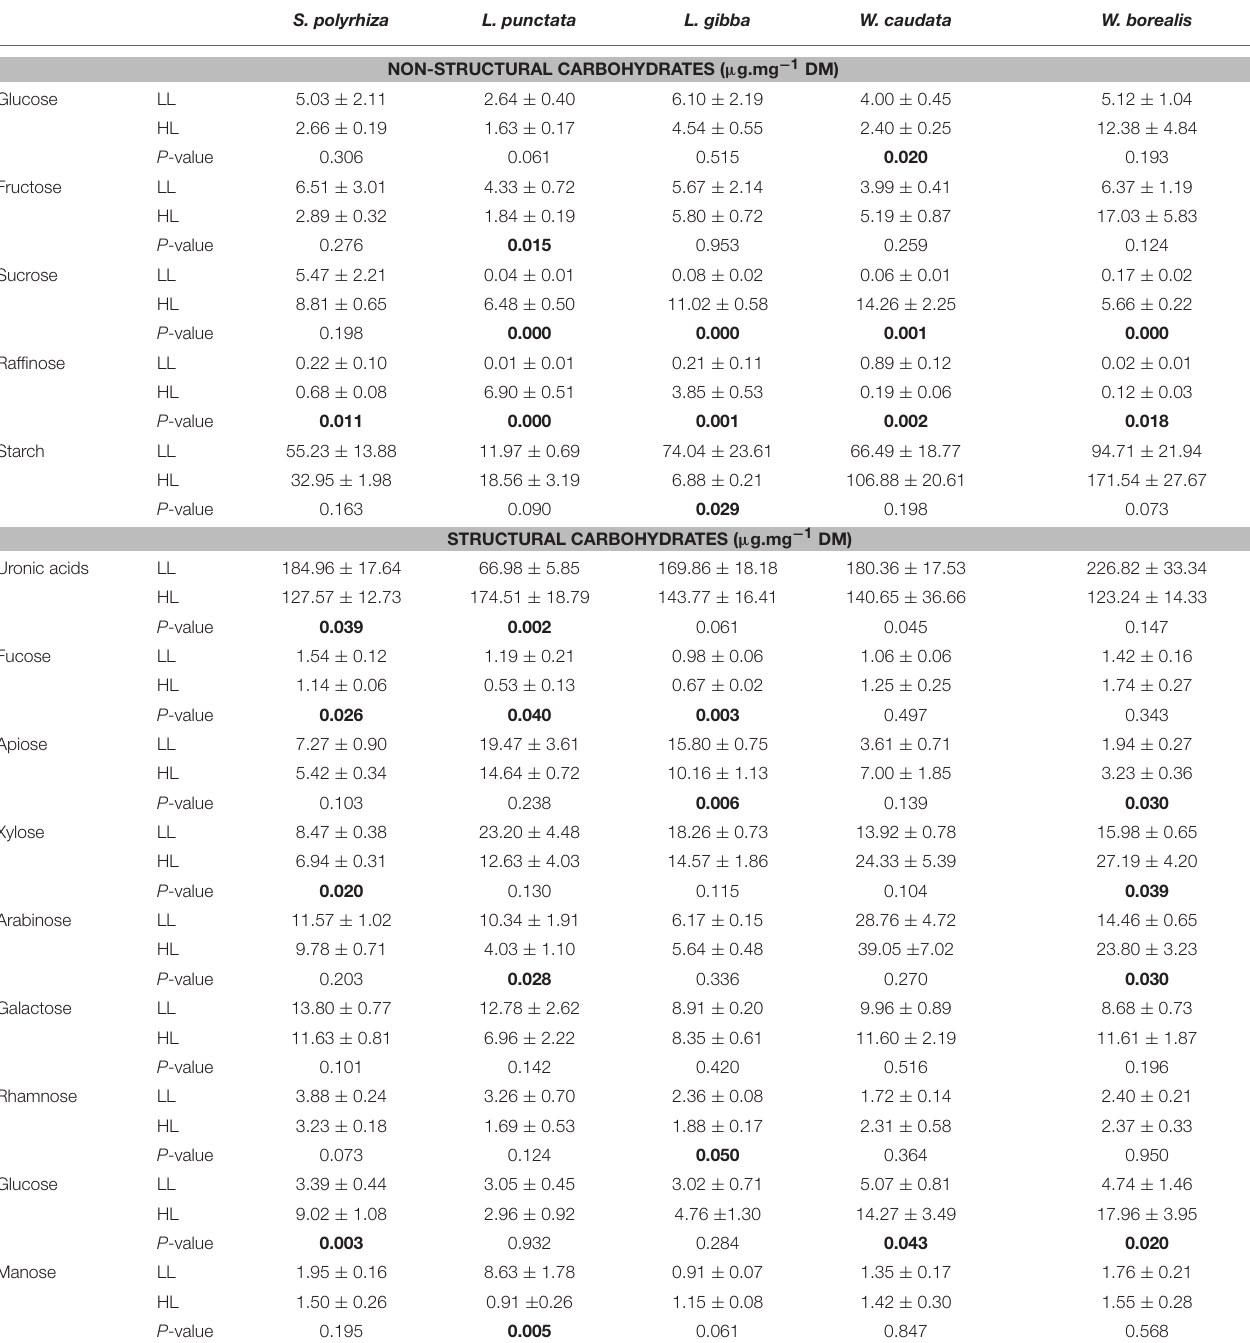
TABLE 1 | Sugar composition of duckweeds ( S. polyrhiza, L. punctata, L. gibba, W. caudata , and W. borealis ) biomass ( µ g.mg − 1 dry mass) cultivated under low light (20 µ mol.m − 2 .s − 1 ) (LL) and high light (500 µ mol.m − 2 .s − 1 ) (HL)